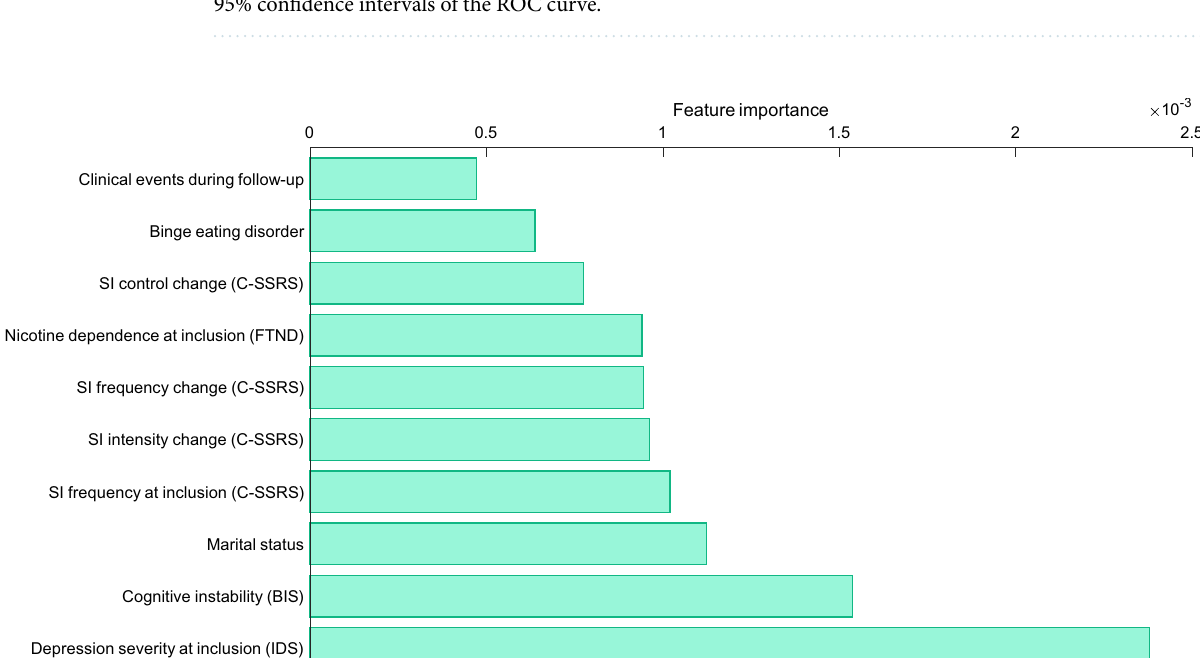
Figure 4. ROC curve. The AUC is 0.74, with 95% CI [0.68, 0.78], estimated by taking 2000 bootstrap samples. Dashed blue line: random guessing reference. Solid red line: mean ROC curve of the automatic prediction of the high-variability group using the selected random forest and clinical features. Green area: AUC. Dashed red lines: 95% confidence intervals of the ROC curve.